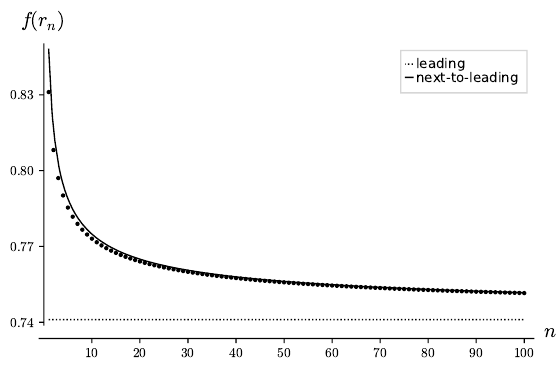
Figure 3 . The values f ( r n ) obtained from the numerical solution of the exact critical vortex equations (black dots), the asymptotic value f ( r n ) = e w 0 (dotted line), and the next-to-leading approximation (solid line) as functions of the winding number n .